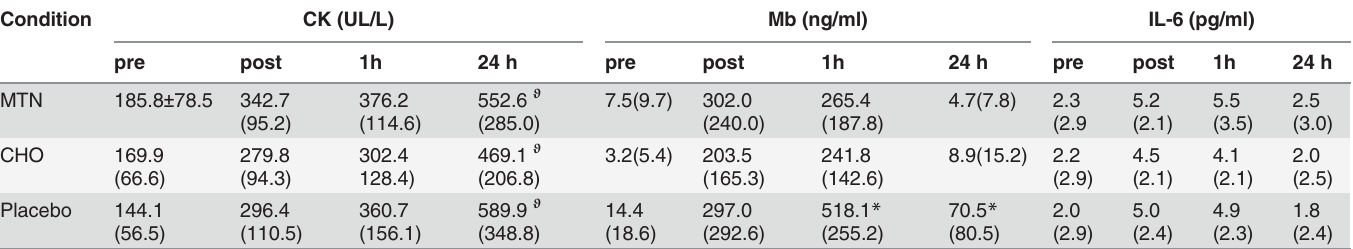
Table 3. Muscle damage markers determined at before (pre), immediately after (post), and 1 h (1h) and 24 h (24h) after intermittent repeated sprint test.